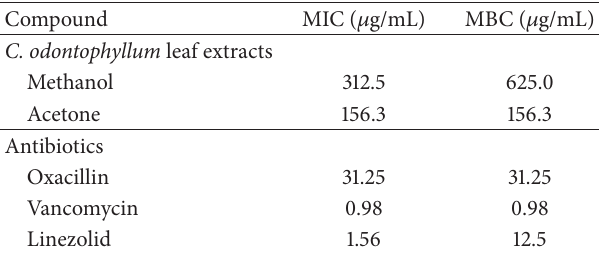
Table 1: Minimum Inhibitory Concentration (MIC) and Minimum Bactericidal Concentration (MBC) values of C. odontophyllum Miq. leaf extracts and antimicrobial agents against MRSA ATCC